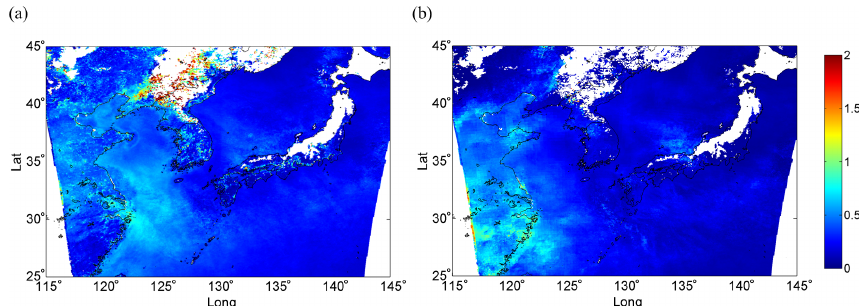
Figure 5. The (a) GOCI- and (b) CMAQ-derived AOD (550nm) during the entire time period of simulations. The values are averaged for February